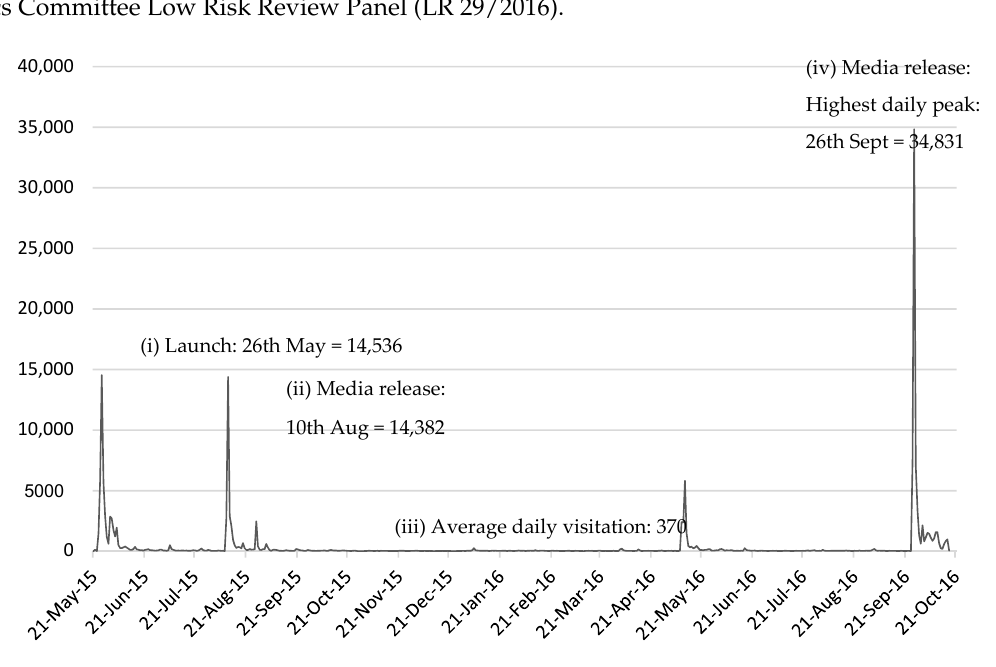
Figure 2. Number of people who have started the CSIRO Healthy Diet Score survey from (i) launch (21 May 2015) to current (17 October 2016) with key peaks in visitation at (ii and iv) the key media releases and (iii) average daily visitation highlighted.